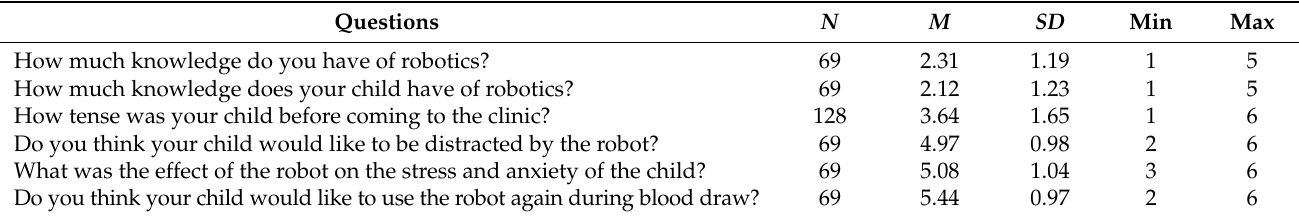
Table 5. Overall perceptions of parents and contextual